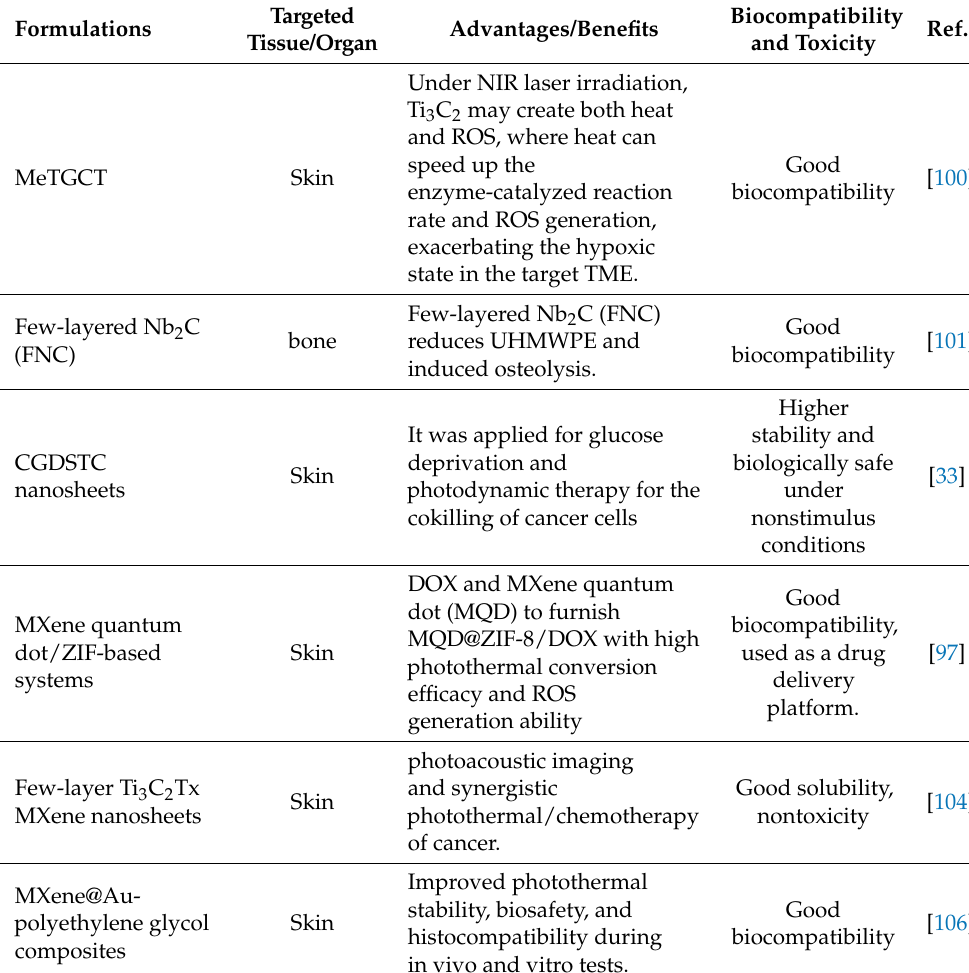
Advantages/Benefits